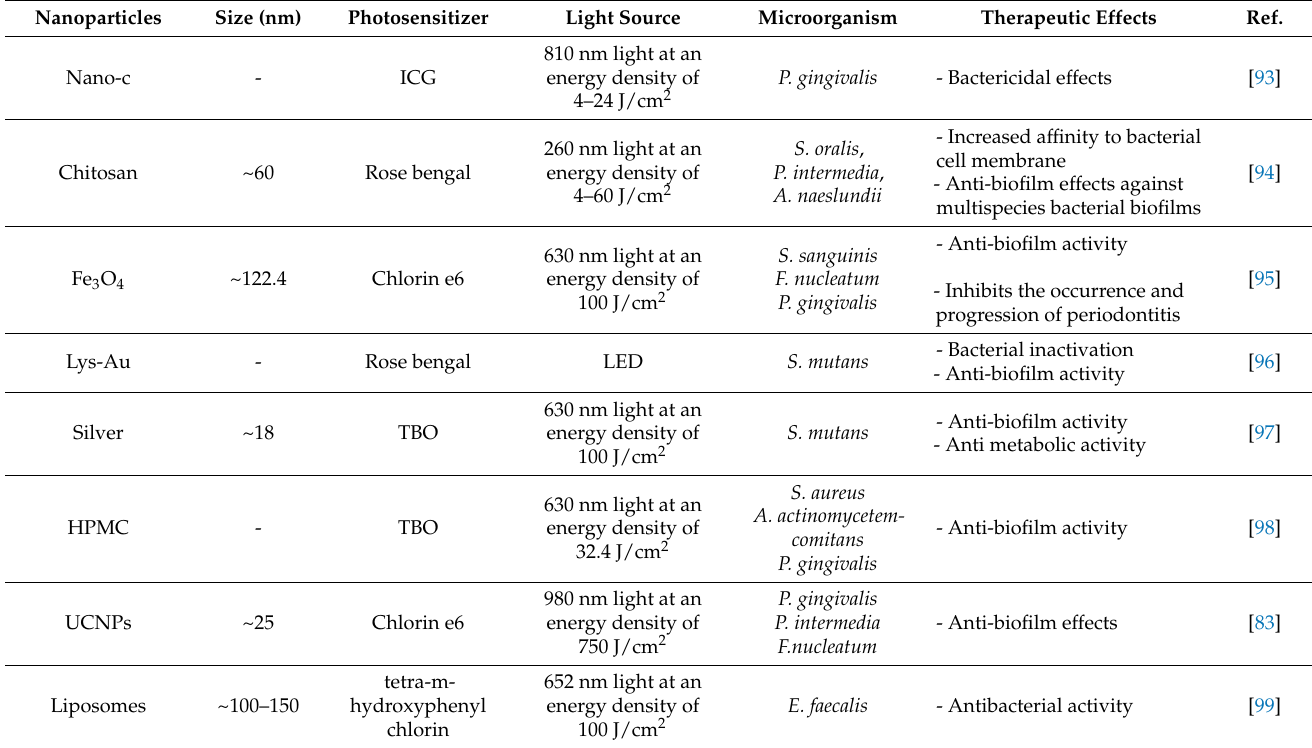
Figure 2. Schematic presentation of antimicrobial photodynamic therapy with nanoparticles against oral biofilm. Nanopar- ticles can accumulate on the membrane surface leading to local deformation and, ultimately, damaging membrane integrity. Photosensitizer-loaded nanoparticle-guided synergistic antimicrobial photodynamic therapy. After entering into the bacteria in the target site, ROS can be effectively produced under the irradiation as shown in the figure. This mechanism can improve the antimicrobial photodynamic therapy function. Table 2. A summary of nanoparticle applications in aPDT against oral bacterial infections.